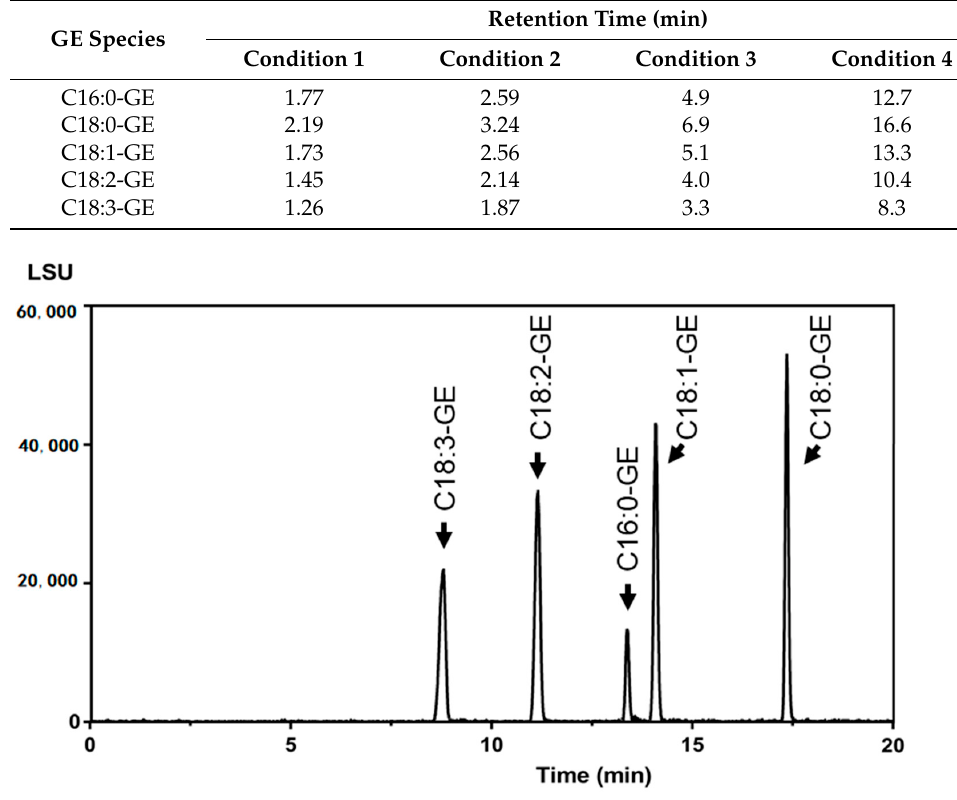
Table 2. Retention times of five glycidyl ester (GE) species analyzed by different UPLC-ELSD methods.